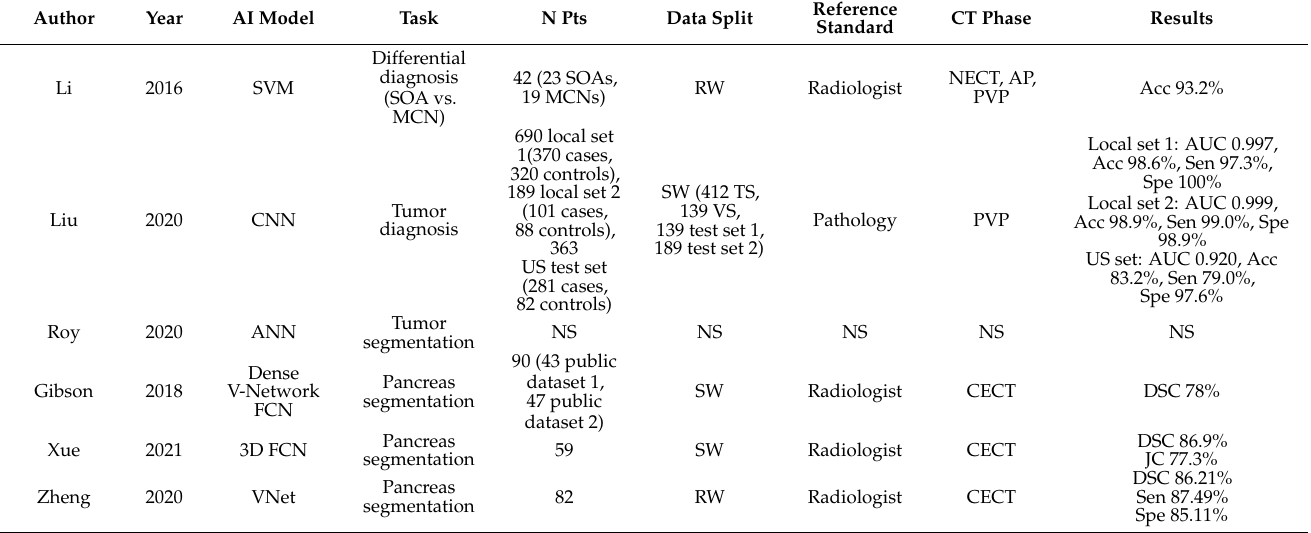
Table 6. Applications of CAD in pancreatic CT